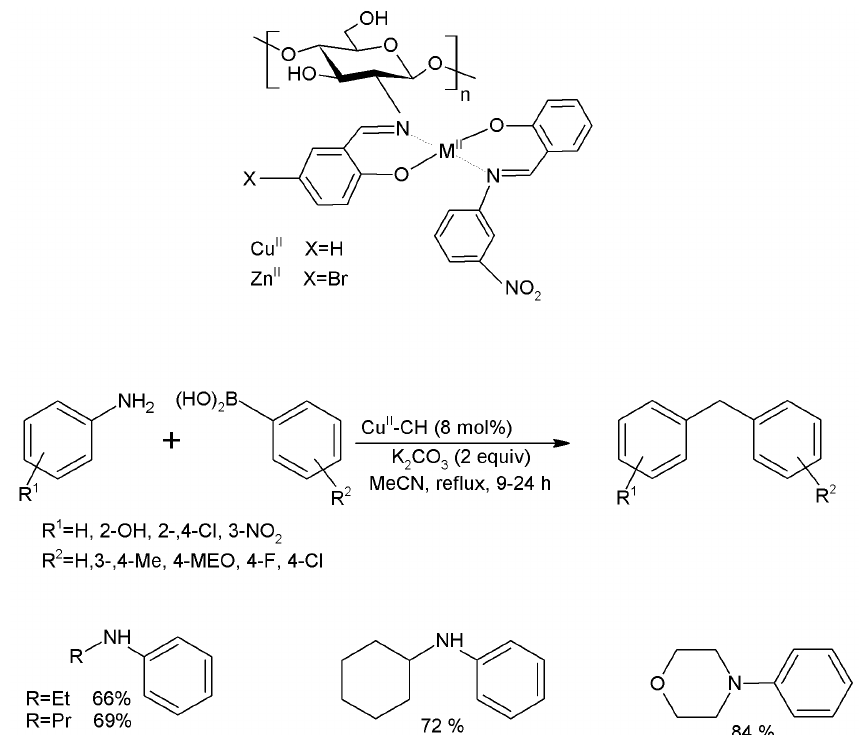
Figure 21. C-N coupling of amines with phenylboronic acids using chitosan-based catalysts loaded with Cu 2 + .